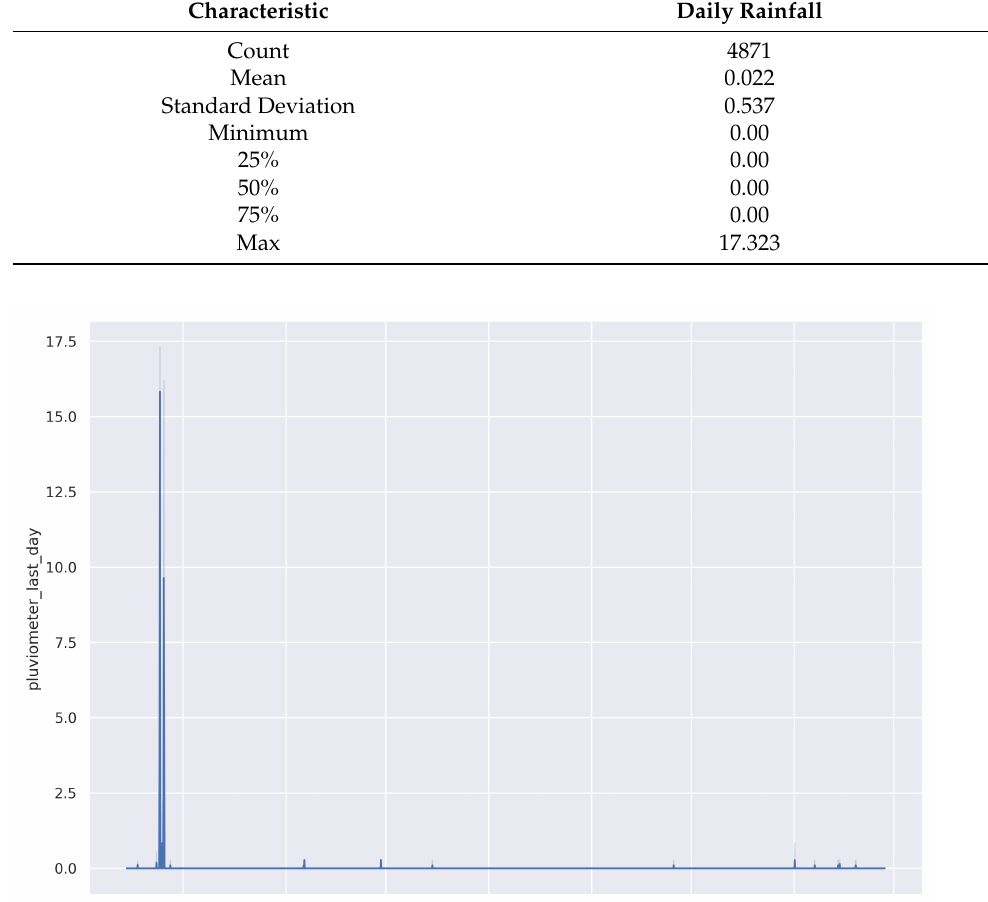
Table 5. Characteristics of rainfall data from one location.